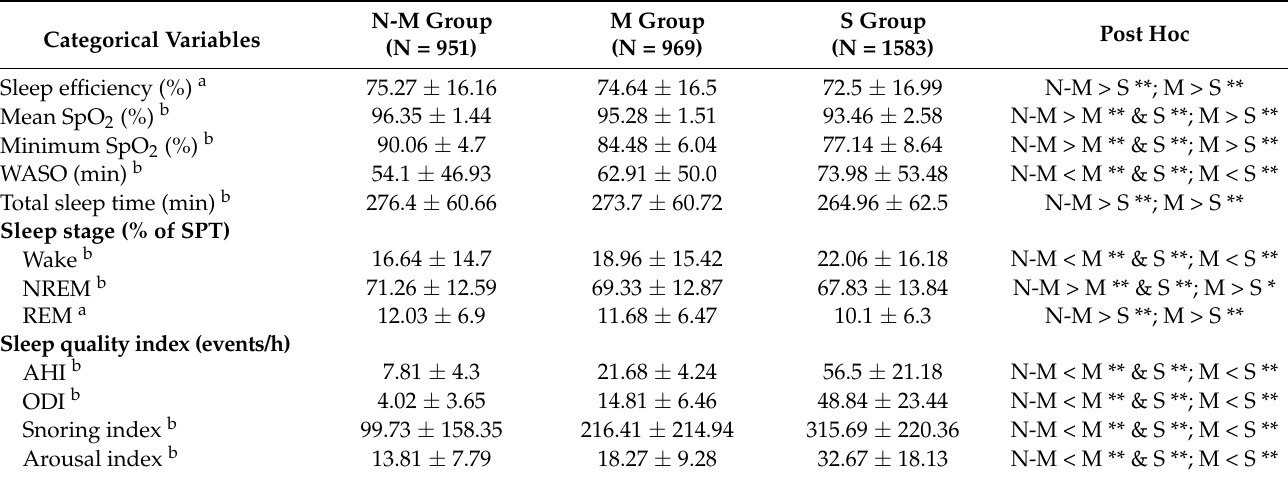
Table 2. Polysomnography parameters of participants grouped by OSA severity.